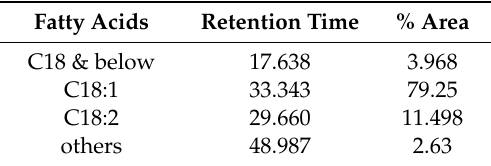
Table 2. Oleic acid composition and retention time.